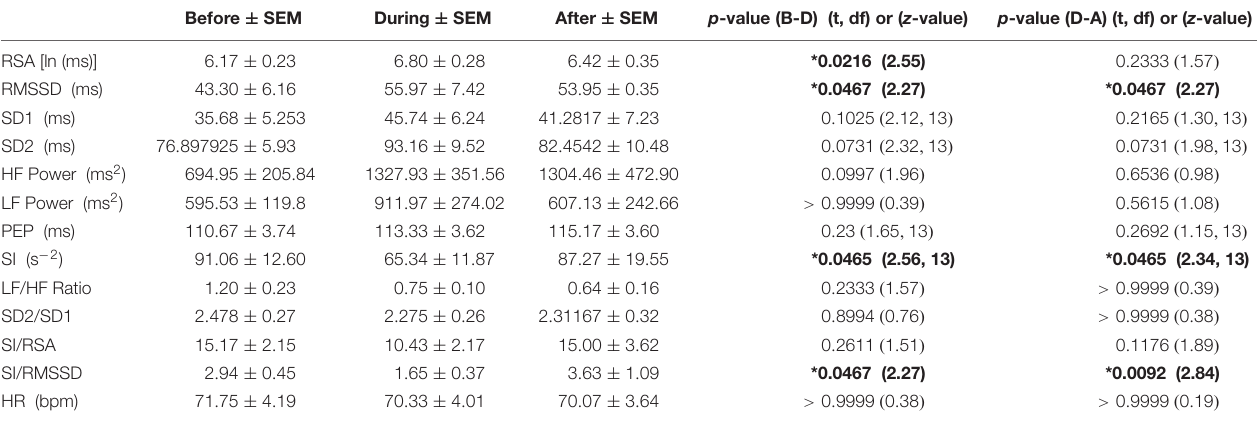
TABLE 3D | HRV parameters associated with HAPWs in response to prucalopride ( n = 14). Before ± SEM During ± SEM After ± SEM p -value (B-D) (t, df) or ( z -value)